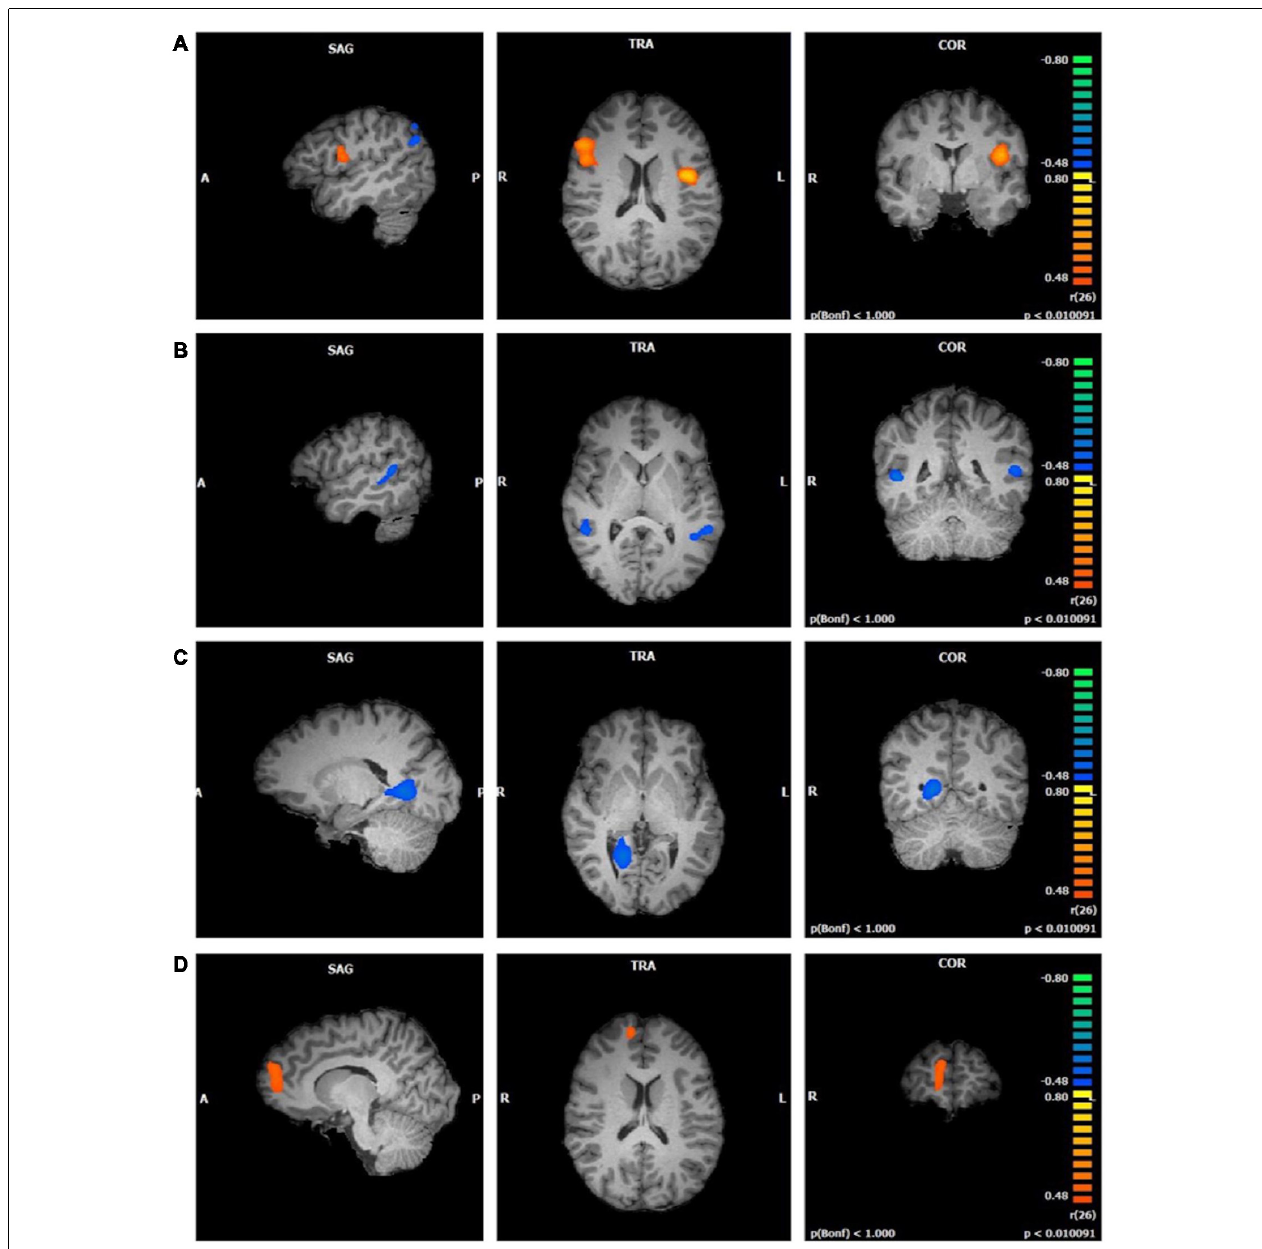
FIGURE 4 | Functional connectivity of attentional network (ATN) clusters correlated with four mindfulness facets ( p < 0.01, cluster threshold estimator corrected). From top to bottom: (A) Observing ; (B) Describing ; (C) Acting ; (D) Non-Judging